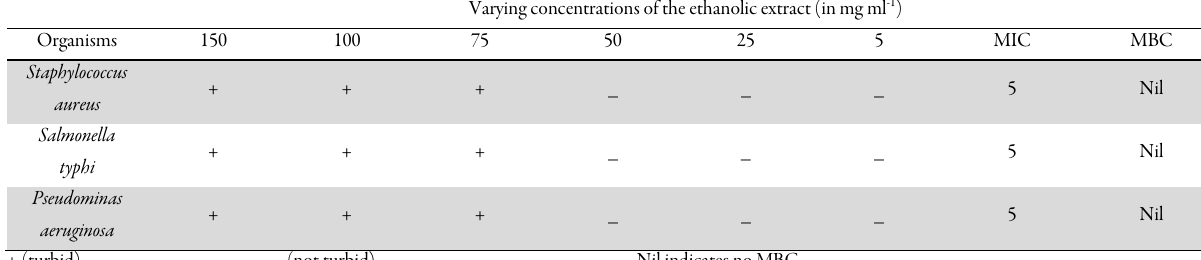
Table 2. Minimum inhibitory and bactericidal concentrations of the ethanolic extract Varying concentrations of the ethanolic extract (in mg ml -1 )